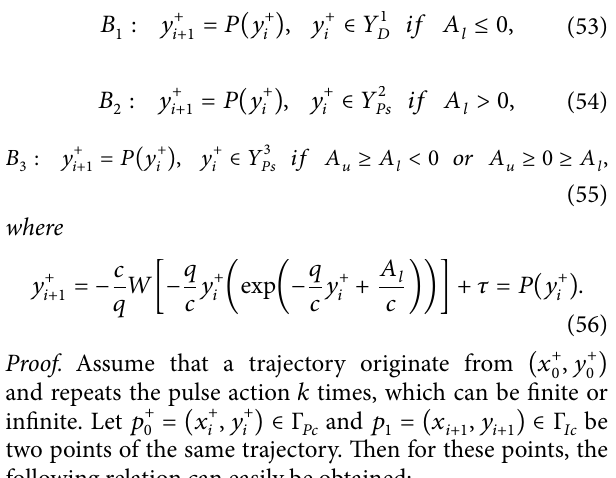
at point 푆 0 = ( 푥 푆 0 , 푦 푆 0 ) Γ 𝑃𝑐